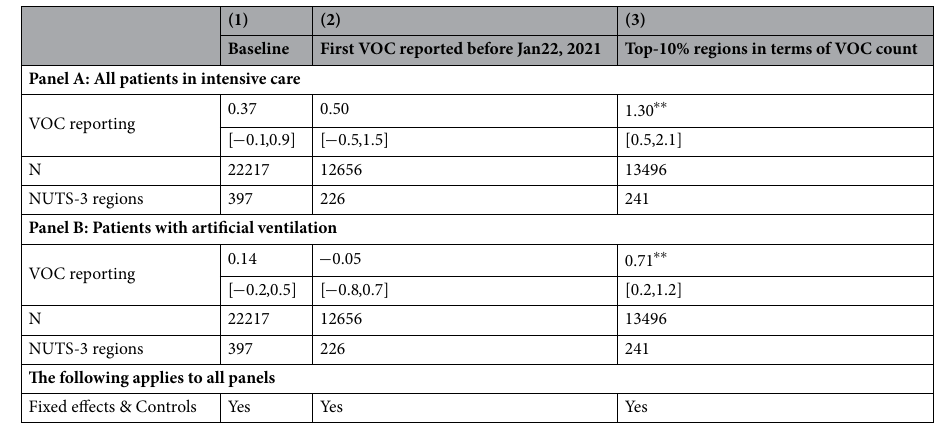
Table 2. Difference-in-difference estimations for association between first reporting of variants of concern and number of COVID-19 patients in intensive care at the local area level in Germany. In Panel A, across columns, the dependent variable is the number of COVID-19 patients in intensive care in a NUTS-3 region at a given day. Panel B is similar but refers to patients in intensive care with artificial ventilation. We always consider the time period between November 15, 2020 and February 4, 2021. In Panel A, we report results for 397 NUTS-3 regions in Germany, for which we have daily data on the number of patients in intensive care. By February 4, 2021, 204 NUTS-3 regions reported a VOC case and 197 did not (Panel B: 30 NUTS-3 regions with at least one reported VOC case before January 22, 2021; Panel C: 45 NUTS-3 regions belonging to the top 10% of sample regions in terms of VOC count). In Panel A, VOC Reporting is a dummy variable defined as one if a VOC case has been reported in a NUTS-3 region, else zero (Panel B: VOC Reporting is one if a VOC case has been reported before January 22; Panel C, VOC Reporting is one if a regions belongs to the top-10% regions in terms of VOC count). Some observations have been dropped because we lack information on some control variables (e.g., on Daily mobility change in relation to 2019 for December 4–7, 2020). We include NUTS-3 and day fixed effects and a linear and a squared trend for four different NUTS-3 region types. We also control for a 1 day, a 7-days and a 14-days lag of the following variables: first, the reported SARS-CoV-2 cases within the previous 7 days, second, the reported SARS-CoV-2 cases within the previous 7 days in neighboring NUTS-3 regions, third, the daily mean temperature at 2 m above ground in ◦ C , and fourth, the daily mobility change in relation to 2019. We include (but do not show) a constant in all regressions. 95% confidence interval based on clustered SE (on NUTS-2 level) in parentheses; + p < 0.1 , ∗ p < 0.05 , ∗∗ p < 0.01